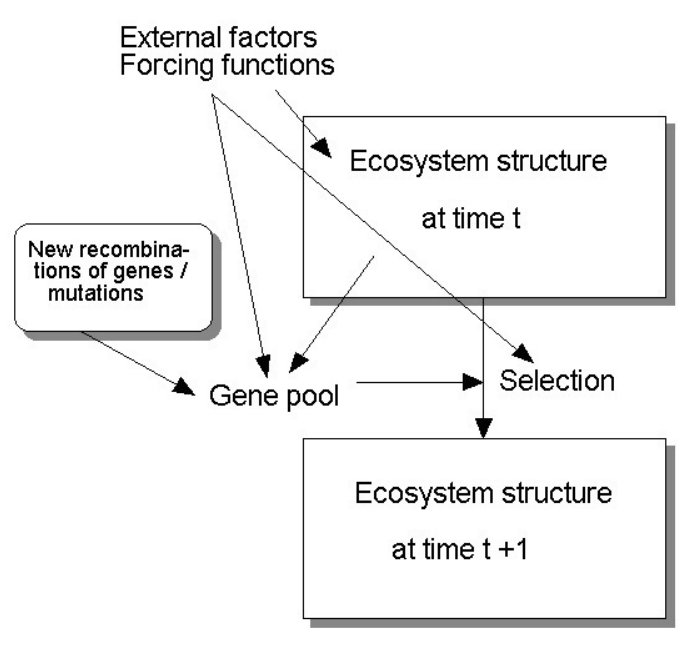
FIGURE 7. Conceptualization of how external factors steadily change the species